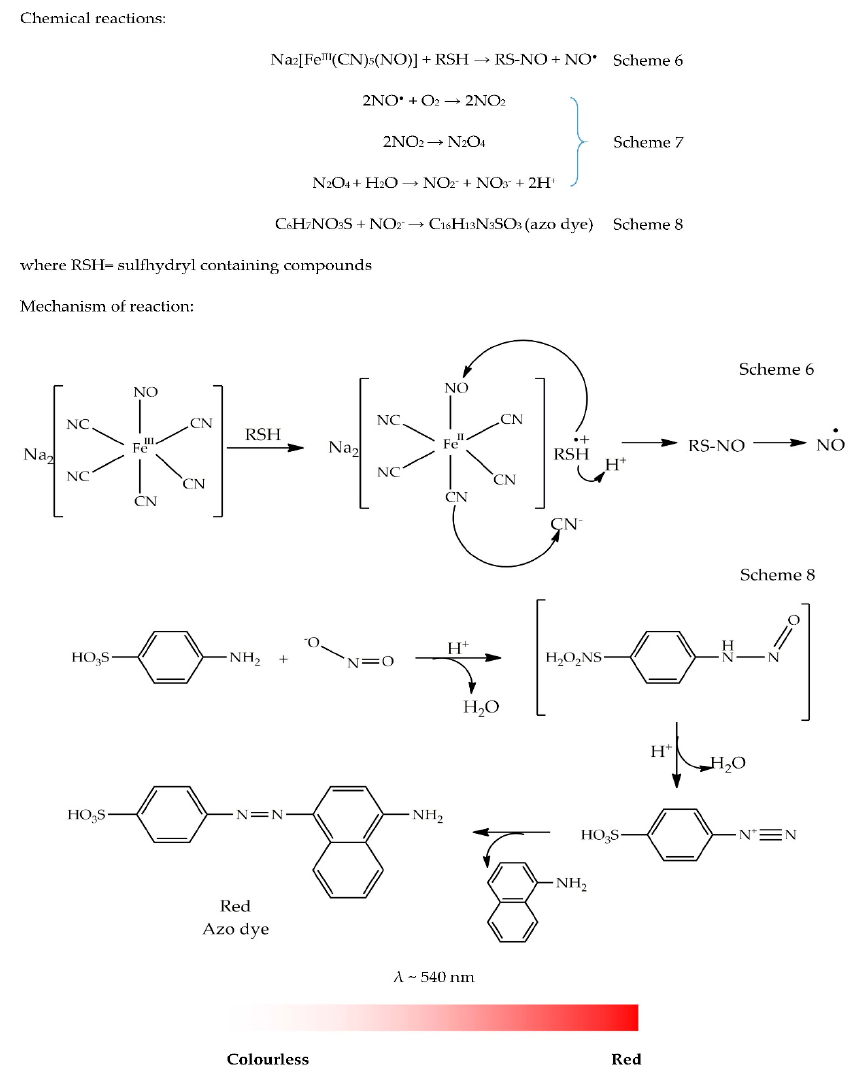
Figure 7. NO • reaction mechanism.